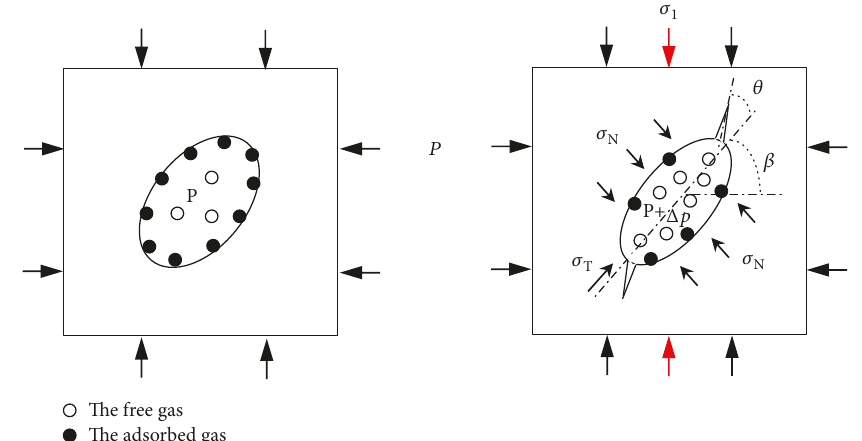
Figure 10: Schematic diagram for the pores deformation of gas-containing coal (a) Initial state, (b) Static loading.